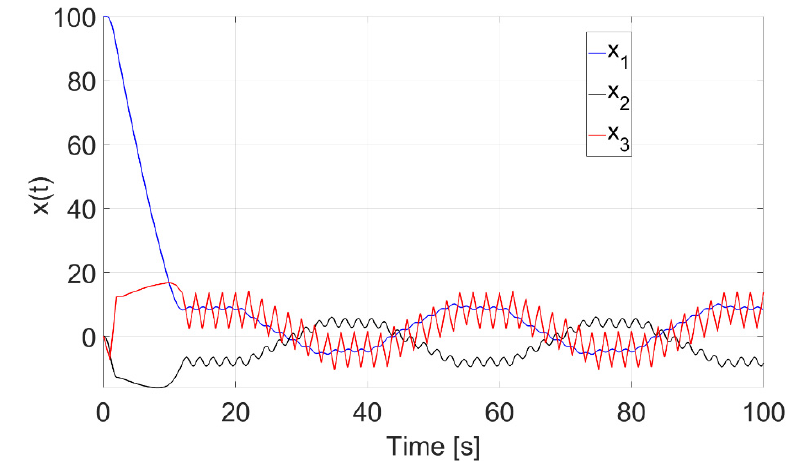
Figure 3. States of the plant controlled by the switching controller.